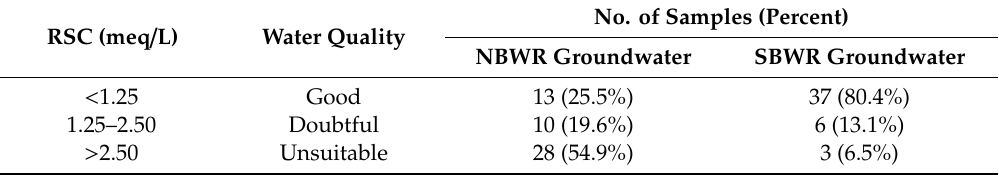
Table 5. The classifications of groundwater quality for irrigation based on the RSC (residual sodium carbonate)